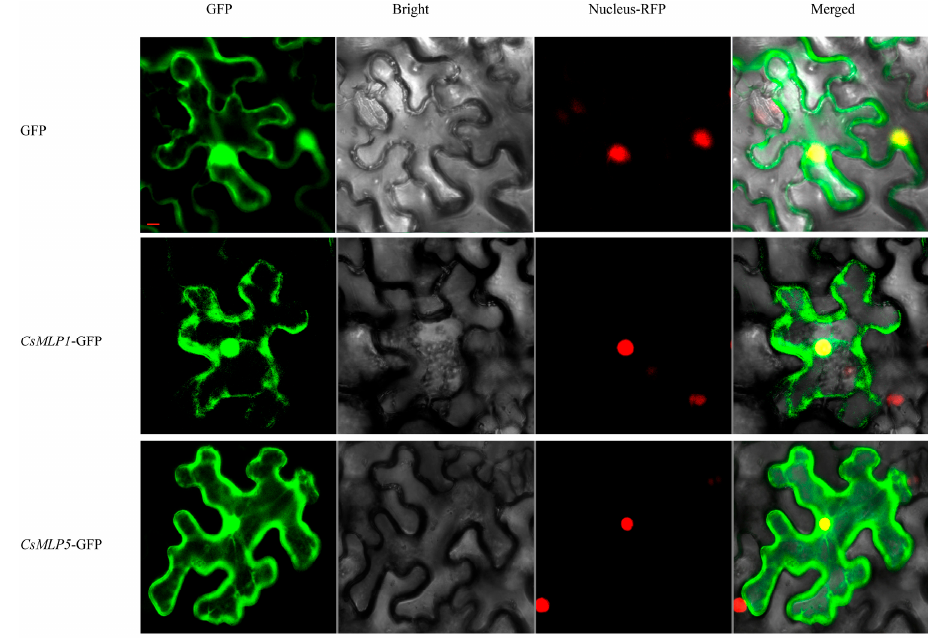
Figure 7. The subcellular localization of CsMLP1 and CsMLP5. Bars, 10